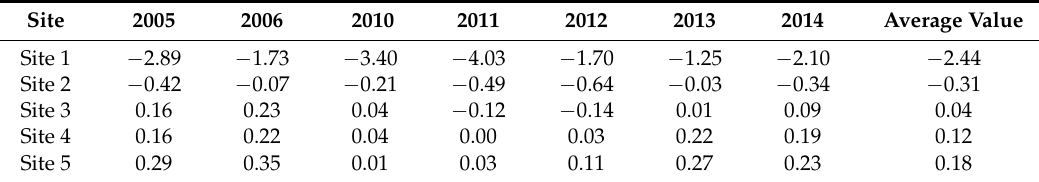
Table 7. Summary of precooling value ratios for the five sites in